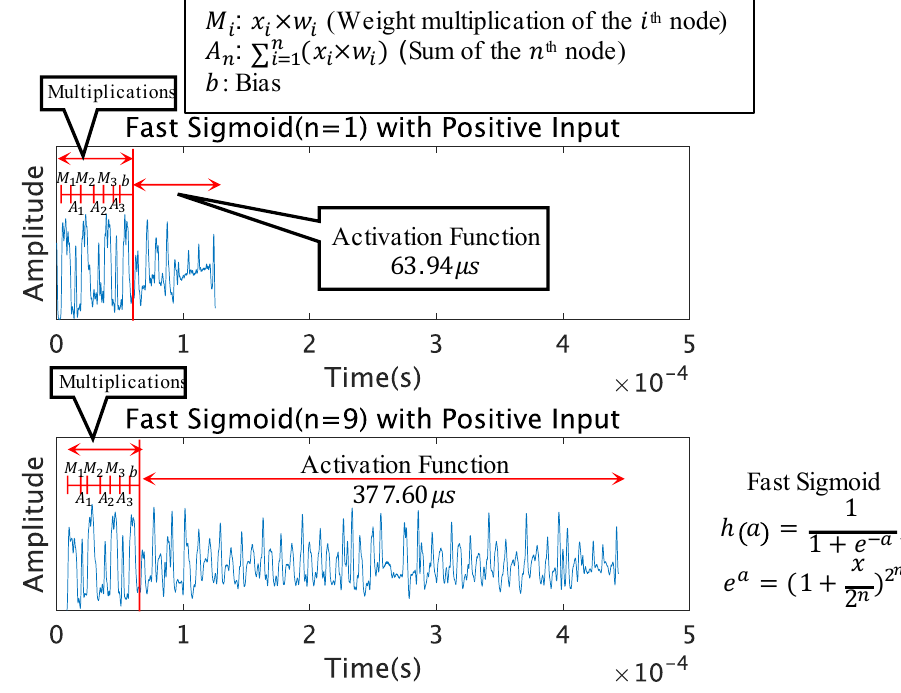
Figure 10. Processed Peak Patterns of Fast Sigmoid